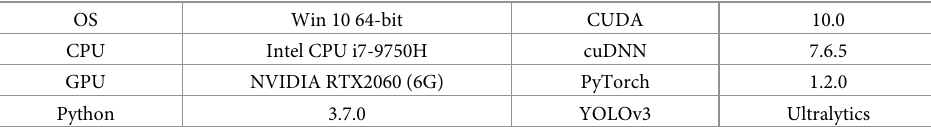
Table 2. Hardware and software